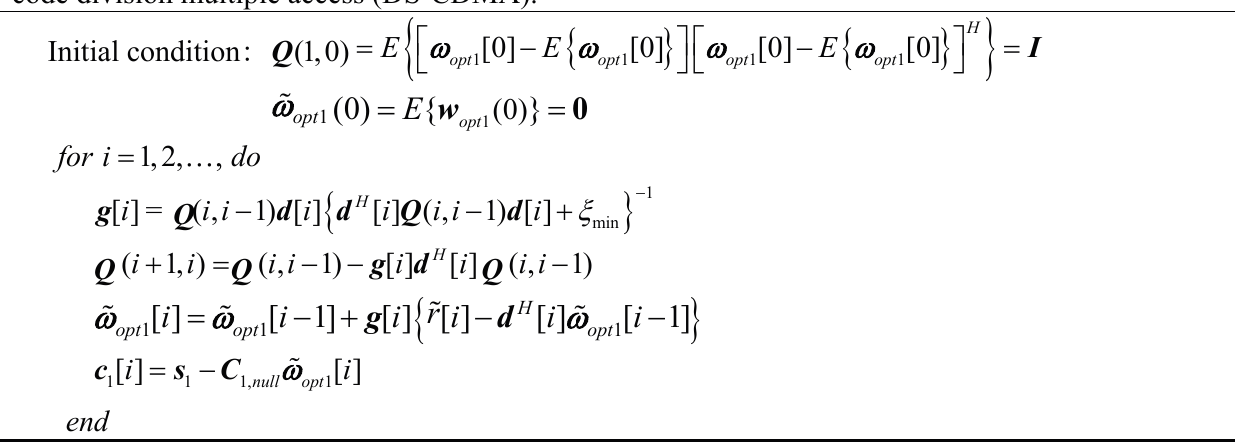
Algorithm 1. Kalman filtering blind adaptive multi-user detector algorithm with direct sequence code division multiple access